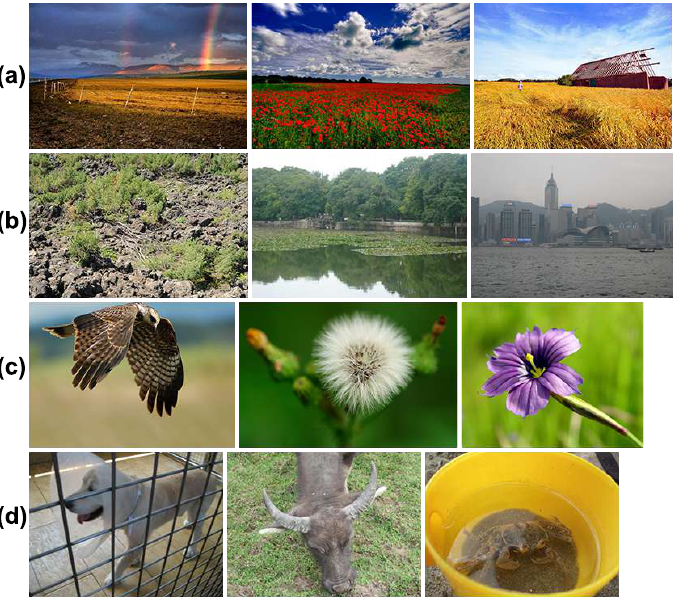
Figure 17. Examples of high and low aesthetic images: ( a ) high aesthetic large field images, ( b ) low aesthetic large field images, ( c ) high aesthetic close-up images, ( d ) low aesthetic close-up